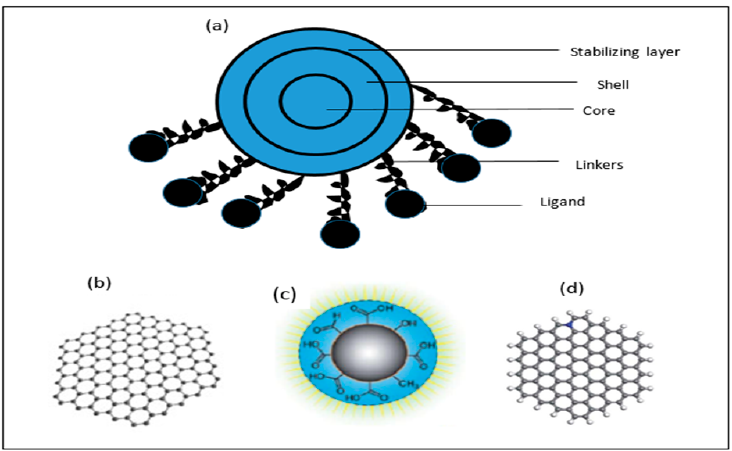
Figure 2. ( a ) The architecture of semiconducting inorganic quantum dots (adapted from [41] with modification); ( b ) Graphene quantum dots; ( c ) Carbon quantum dots (reproduced with permission [69]-published by the Royal Society of Chemistry); ( d ) Heteroatom (blue atom) doped graphene quantum dots.